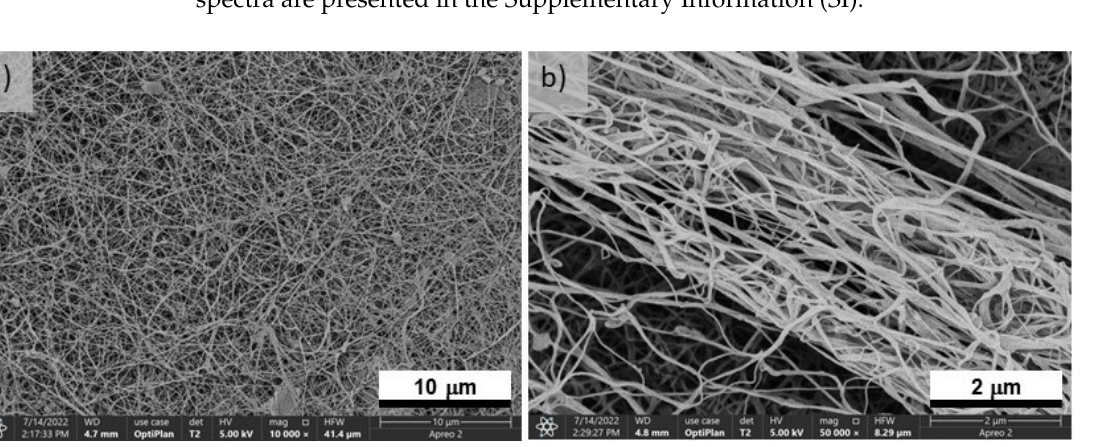
Figure 2. SEM micrographs at ×50,000 of BNCA-Pat 500 °C ( a , b ) and at 600 °C ( c , d ). P area: clusters of phosphorus particles.